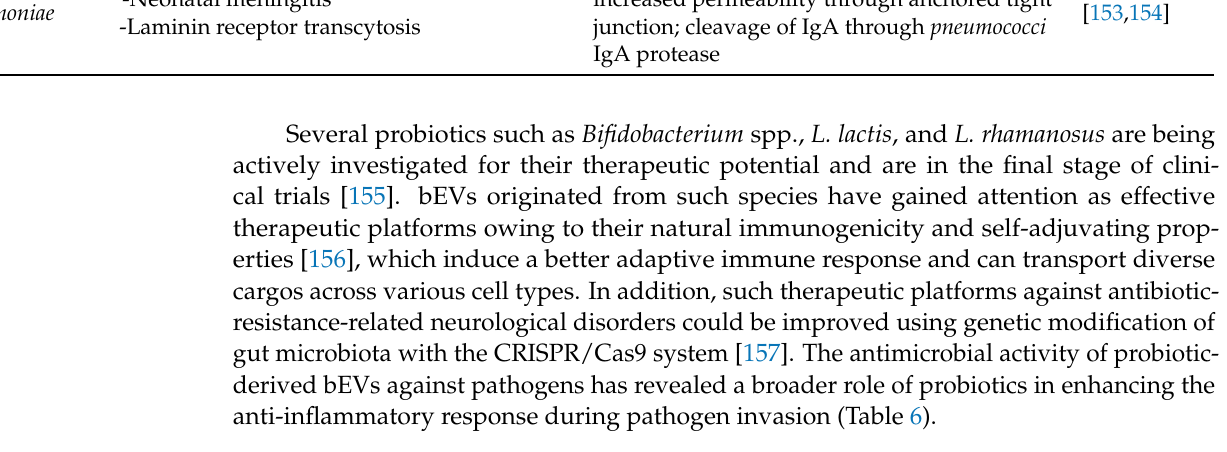
Table 6. Probiotic-derived bEVs against BBB-invading